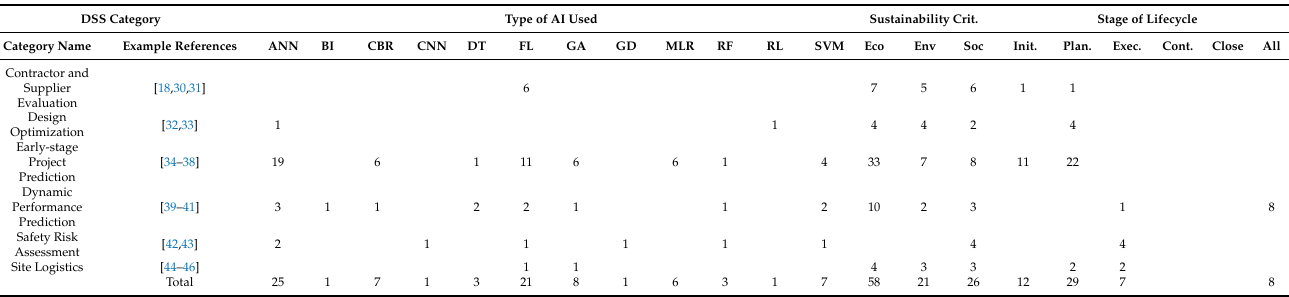
Table 2. A table of the count of types of AI, sustainability criteria, and the stage of construction against each category of DSS.